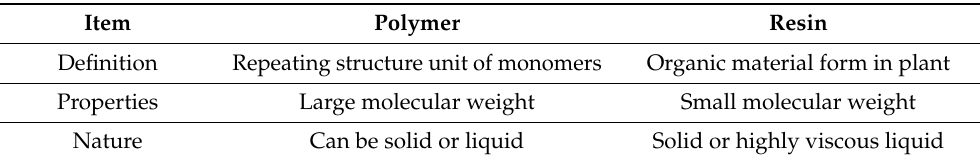
Table 5. Differences between polymer and resin